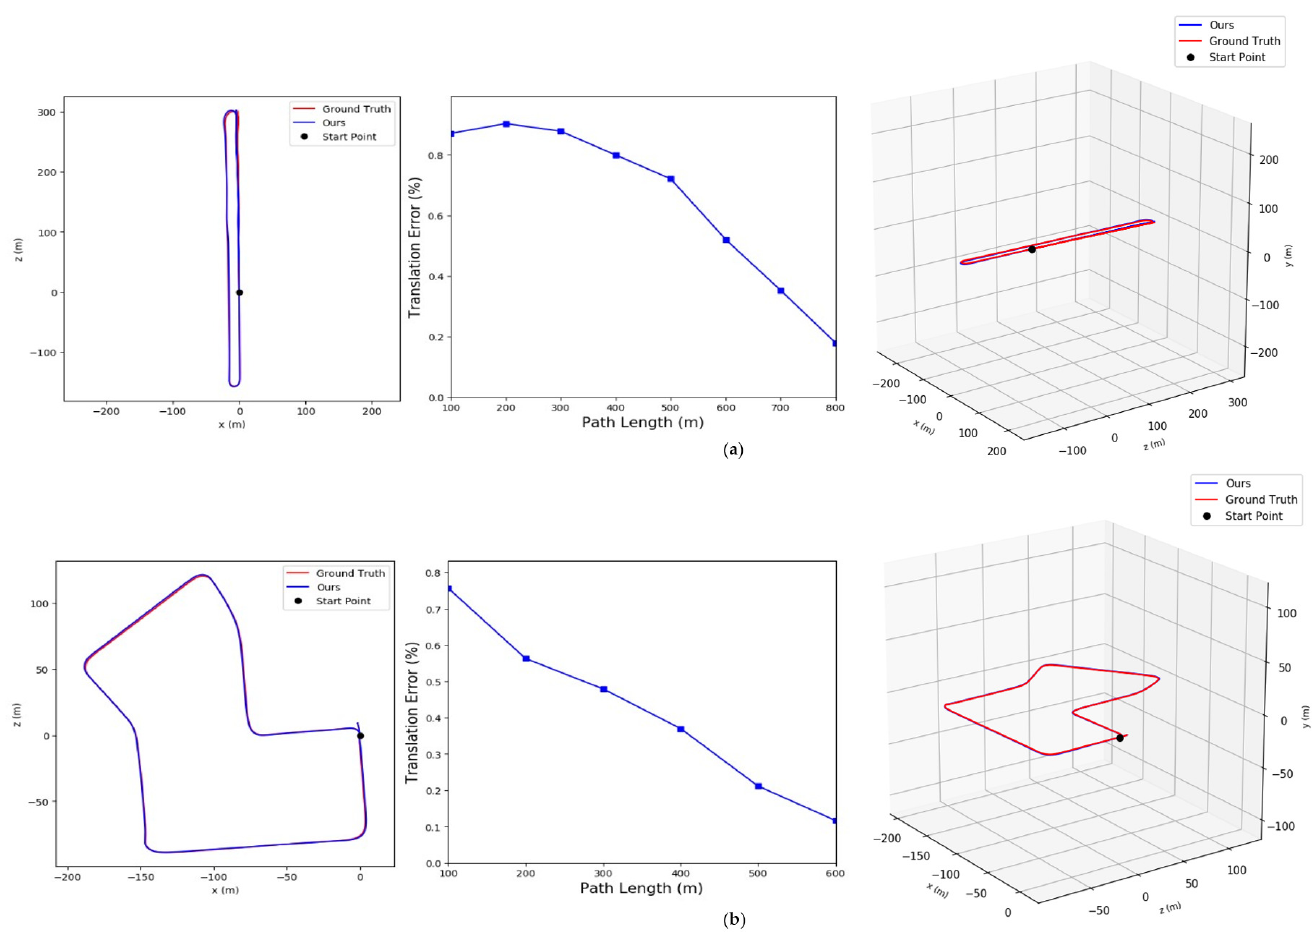
Figure 6. The average translation error between our method and ground-truth: ( a ) Results in sequence 06, ( b ) Results in sequence